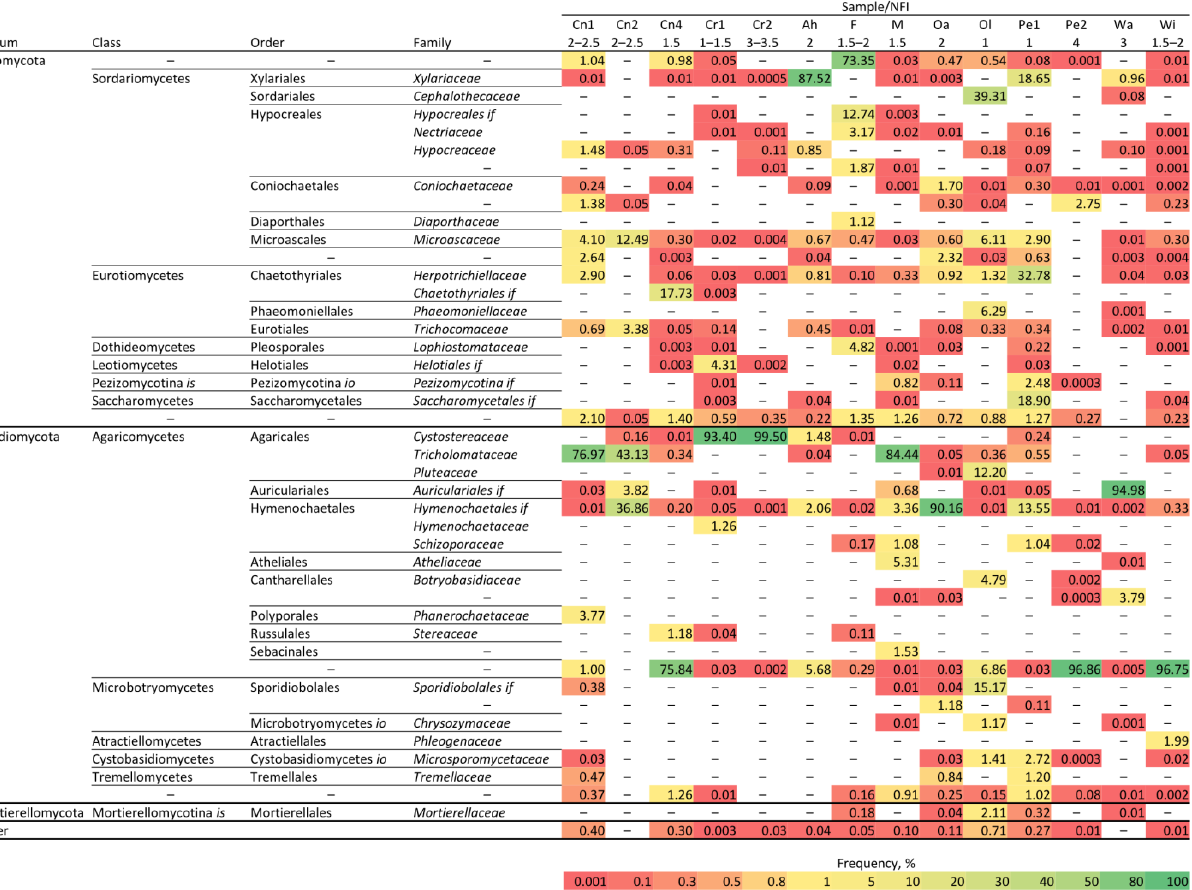
Figure 3. OTU taxonomic analysis at the family level of the fungal fraction of rotting wood samples.